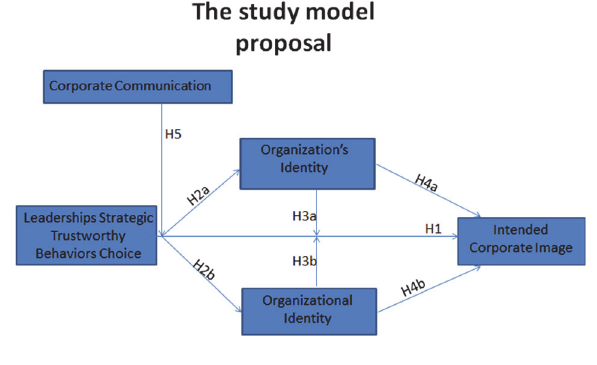
Fig. 1. The proposed